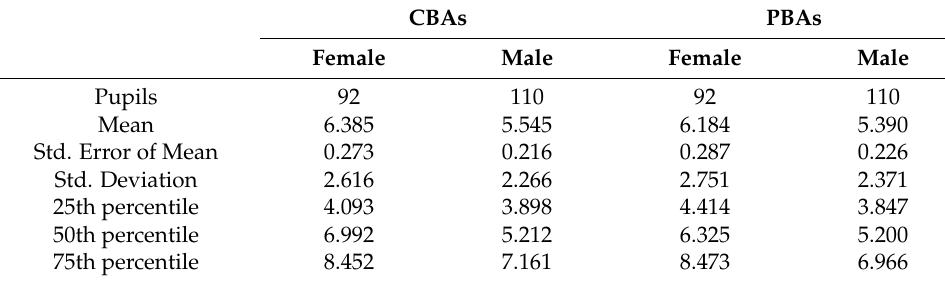
Table 5. Descriptive PRSs statistics of Female and Male pupils in CBA and PBA mode.